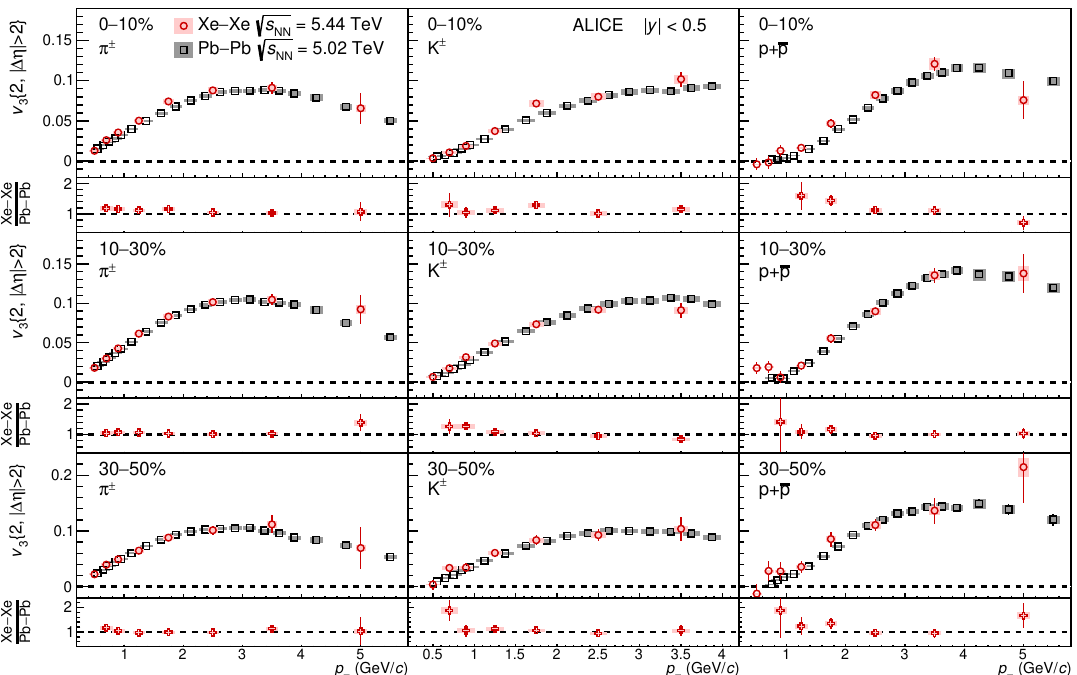
Figure 13. The p T -differential v 3 of π ± , K ± , and p+ p (black markers) compared to ALICE √ measurements performed in Pb-Pb collisions at s NN = 5.02 TeV [32] (red markers) for the 0–10% (top panels), 10–30% (middle panels), and 30–50% (bottom panels) centrality classes. The ratios of Xe-Xe measurements to a cubic spline fit to Pb-Pb measurements are also presented for clarity. Bars (boxes) denote statistical (systematic)